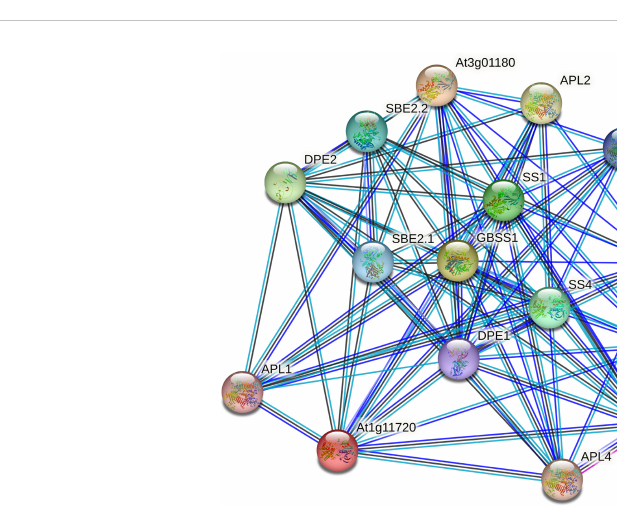
FIGURE 7 Interaction network of GhSS